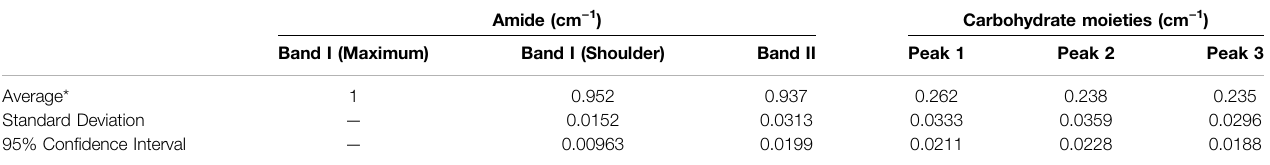
TABLE 1 | Descriptive statistics of maximum infrared absorbance values obtained from normalized spectra acquired from non-cross-linked collagen gel samples.